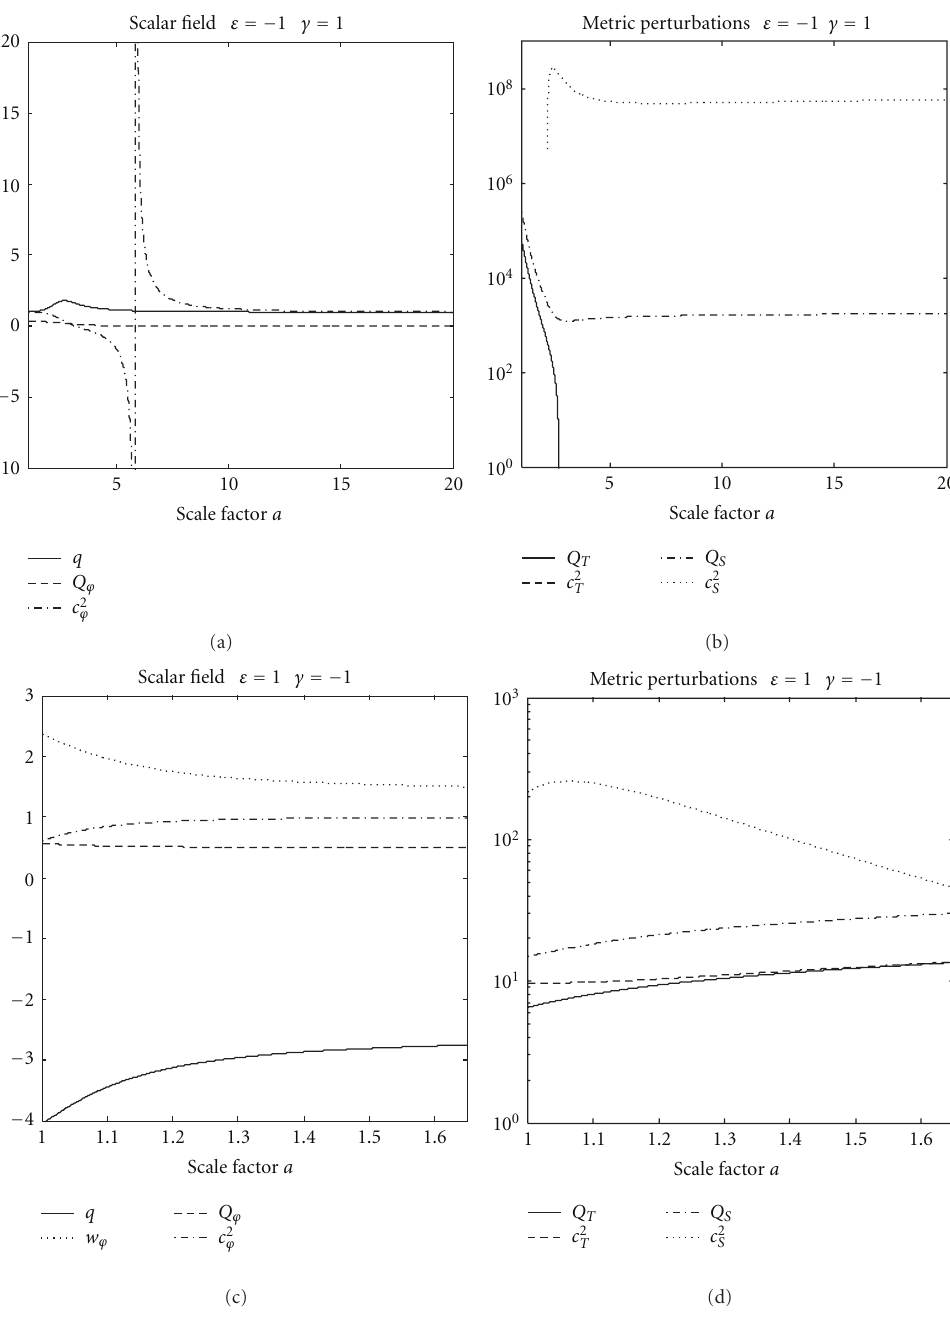
Figure 10: Cosmological evolution of q , Q ϕ , c 2 inflation.” The scenario is pathological in many respects: singularity in the scalar field velocity (see (a)) while the scalar field EoS is imaginary. Also (see (b), the y axis is logarithmic): c 2 The model is well behaved but does not accelerate the expansion, that is, as in the John alone model. The universe is actually in a super sti ff regime and hence in a highly decelerating